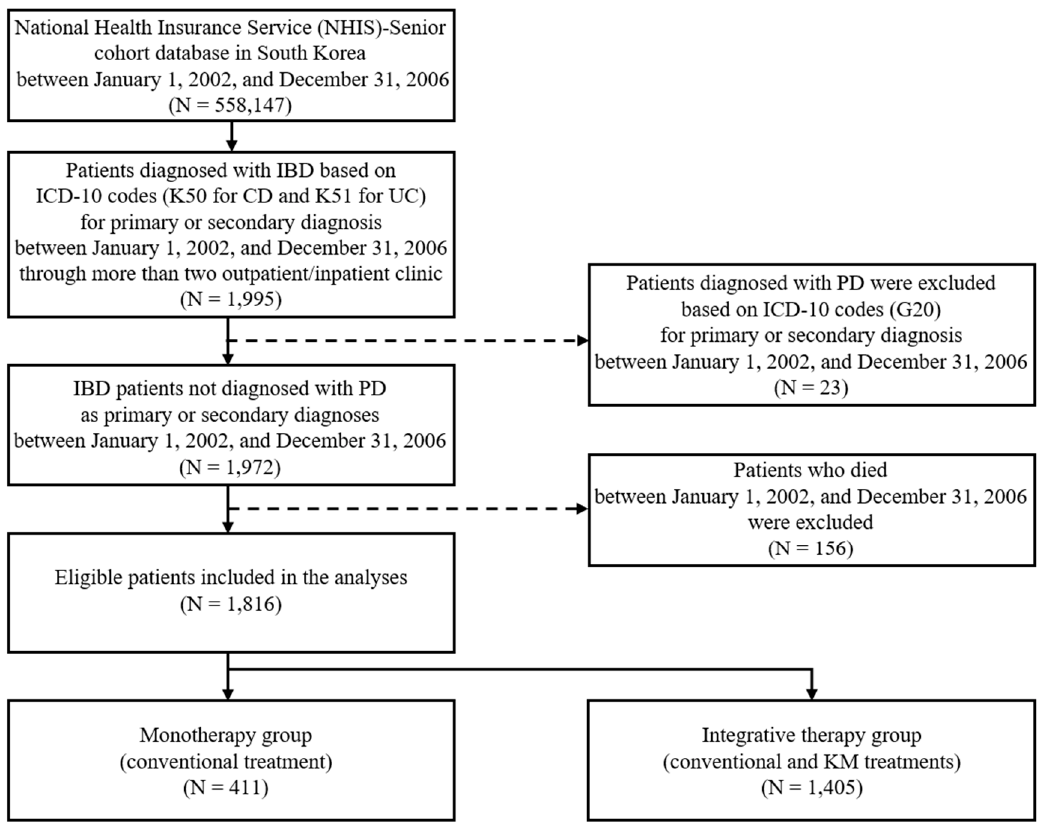
Figure 1. Flowchart of the study population. CD: Crohn’s disease, IBD: Inflammatory bowel disease,